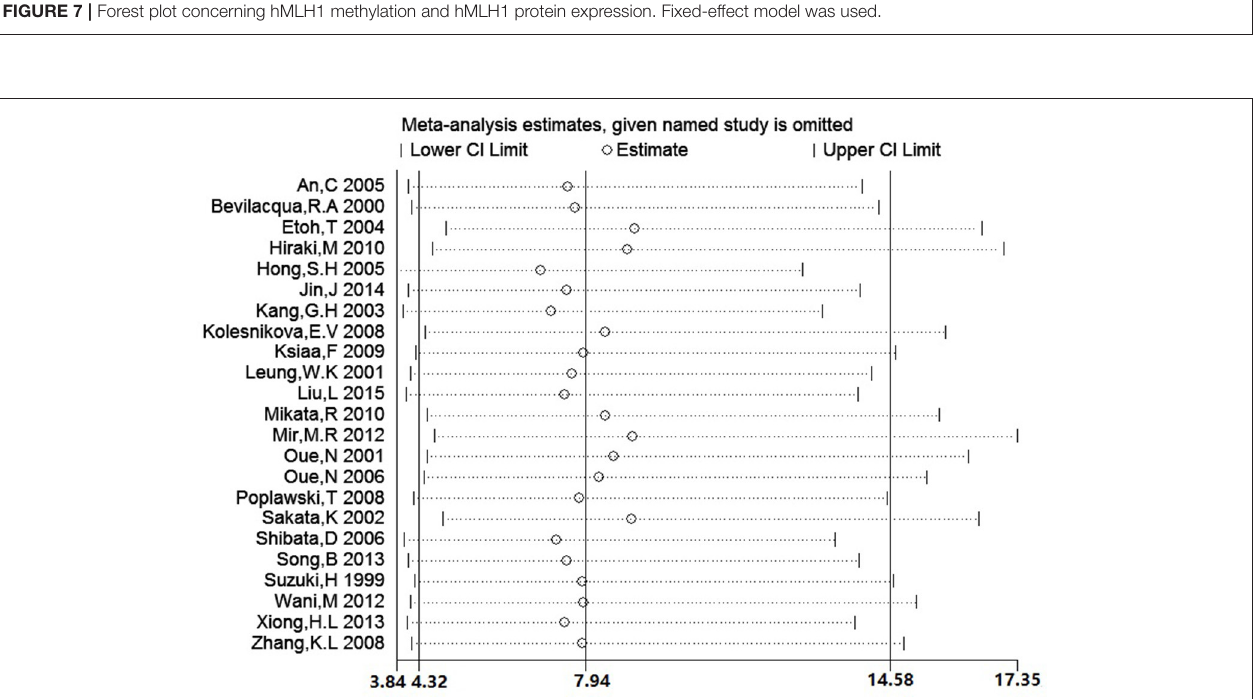
Frontiers in Physiology | www.frontiersin.org